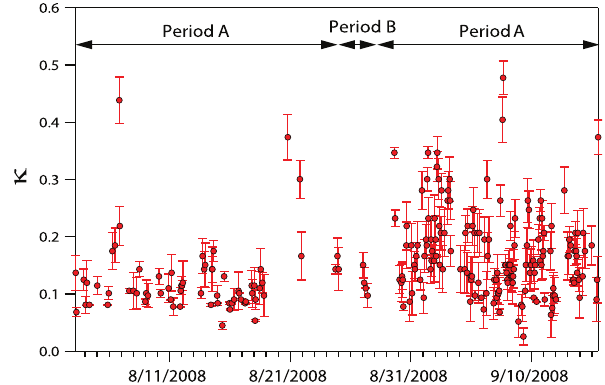
Fig. 11. Time-series of the characteristic hygroscopicity parameter ( κ ∗ ; red circles) and its variability (error bars represented by σ k ) for 80nm particles. Period A correspond to air masses originating from the continental US; while period B corresponds to air masses originating from either the Atlantic Ocean or Gulf of Mexico. Gaps in data are a result of power outage or instrument